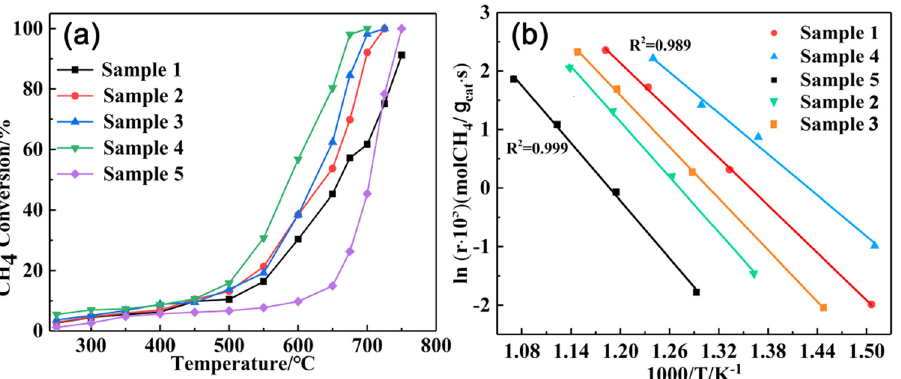
Figure 4: ( a ) E ff ect of calcination temperature on methane conversion; ( b ) Arrhenius plots for the oxidation of methane over the catalysts.